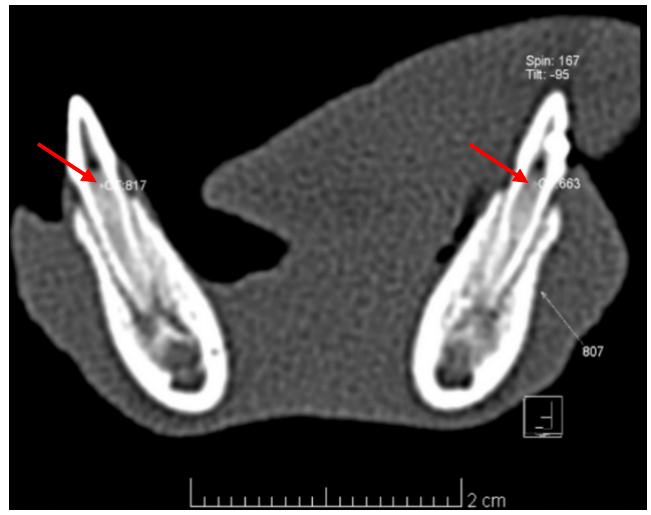
Figure 5. Axial CT slice of 0.6 mm thickness for teeth 807 (14 days after Biodentine TM DPC) and 707 (control) with pulp density measurements (expressed in HU), red arrow: conducted at the same level for both teeth (CT: 663 HU in tooth 807 and CT:817 HU in tooth 707). Table 2. Average values of pulp density (HU) measured on CT scans in all treated and control